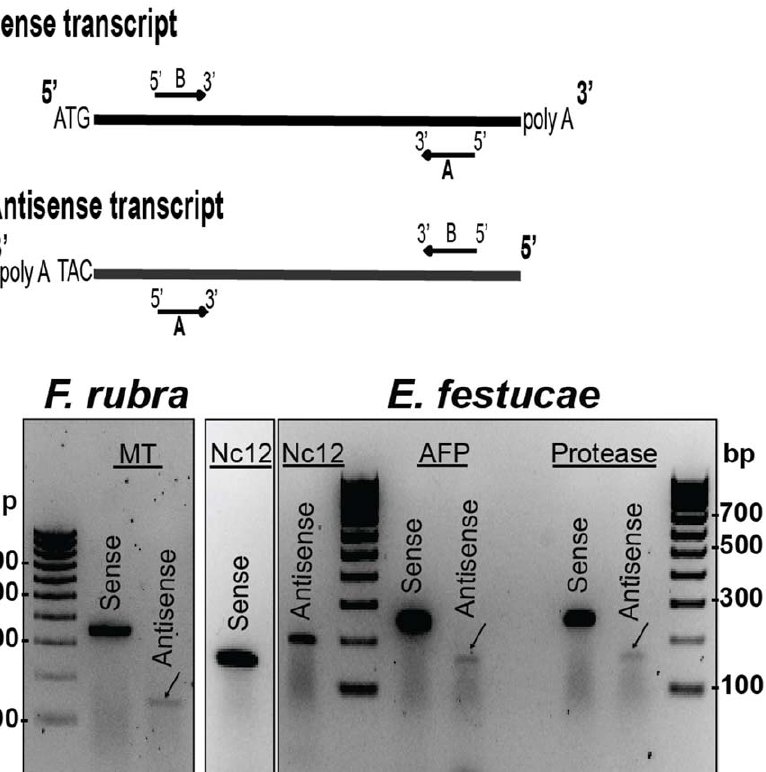
Figure 1. Gel analysis of F.rubra and E.festucae antisense transcripts. The diagram illustrates primer design for detection of sense and antisense transcripts. The ‘‘A’’ primers were used for strand specific synthesis of cDNA from the RNA sample. The ‘‘A’’ and ‘‘B’’ primers were used for cDNA amplification. cDNAs generated from gene-specific primers for the F. rubra metallothionein (MT) and the E. festucae NC12, antifungal protein (AFP), and subtilisin-like protease were used as templates for PCR amplification.